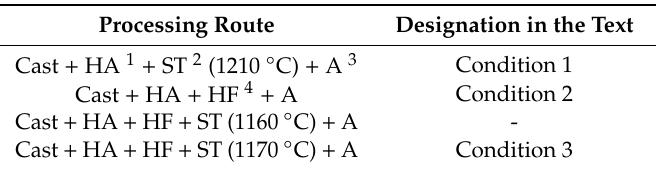
Table 1. Processing of the SDZhS-15